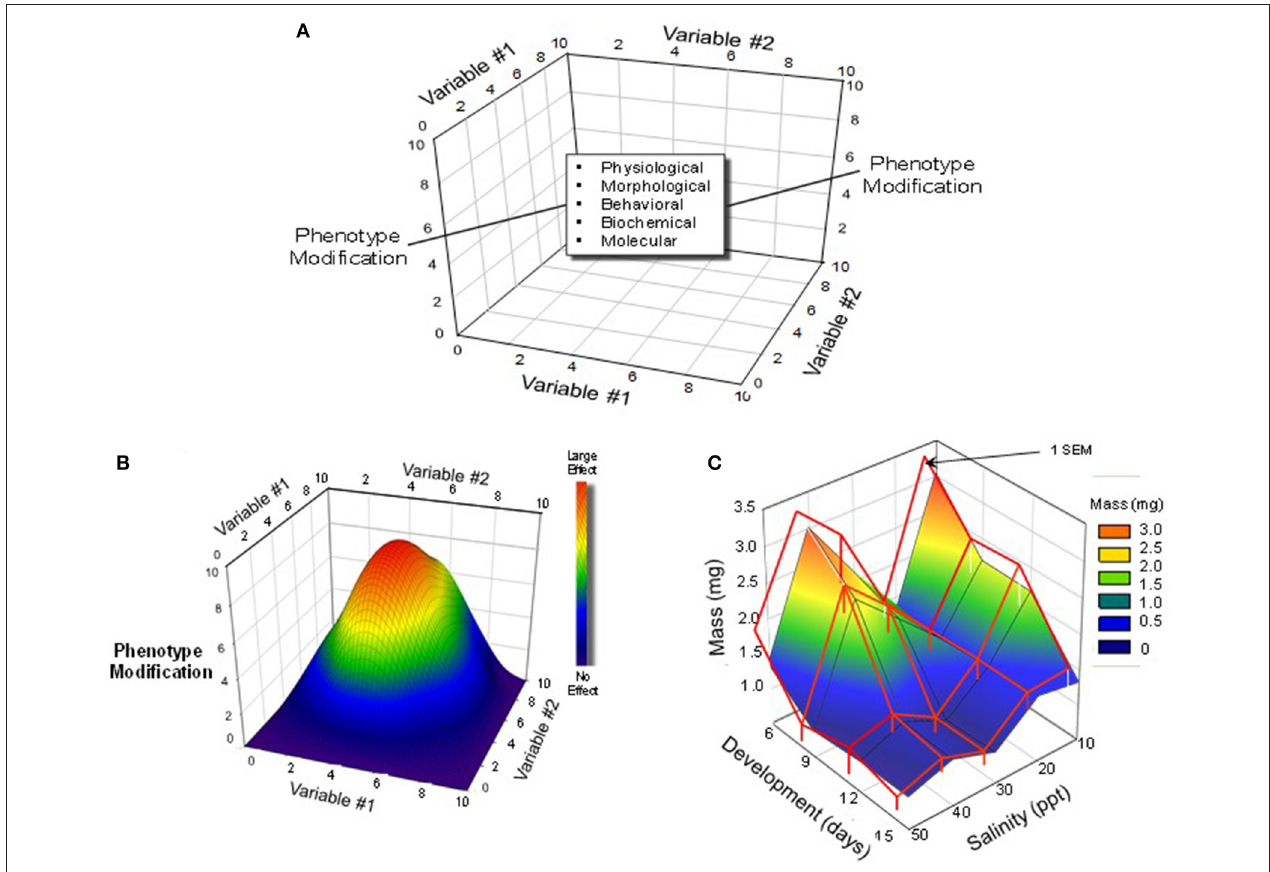
FIGURE 3 | Multi-variable experimental designs and possible outcomes. (A) A three-dimensional schematic depiction of a protocol that would employ multiple levels/concentrations/doses of multiple variables. (B) A hypothetical outcome on a developing animals phenotype produced by simultaneous variation in two different variables. In this schematic, the largest effect is created by a combination of intermediate levels Variable #1 and Variable #2. Modified from Burggren and Mueller (2015). (C) An actual example of interactions between development (Variable #1) and rearing salinity (Variable #2) in the brine shrimp Artemia franciscana . Note that there was an unexpected bimodal effect of rearing salinity, with the largest effect appearing early in development. Modified from Mueller et al. (2016).